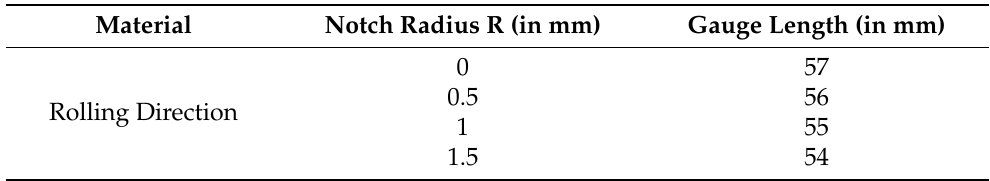
Figure 3. CAD design of tensile test specimens. ( a ) Un-notched specimen. ( b ) Notched specimen. Table 2. Notch radius and gauge length of the studied